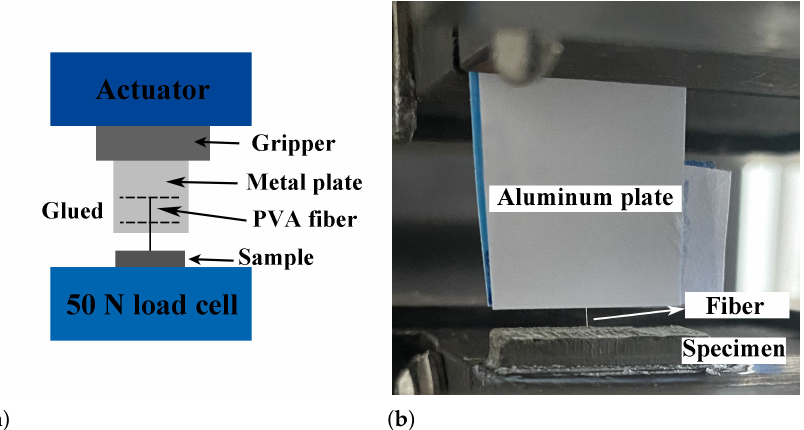
Figure 6. Single fiber pull-out tests. ( a ) Detailed description of test and ( b ) schematic diagram of